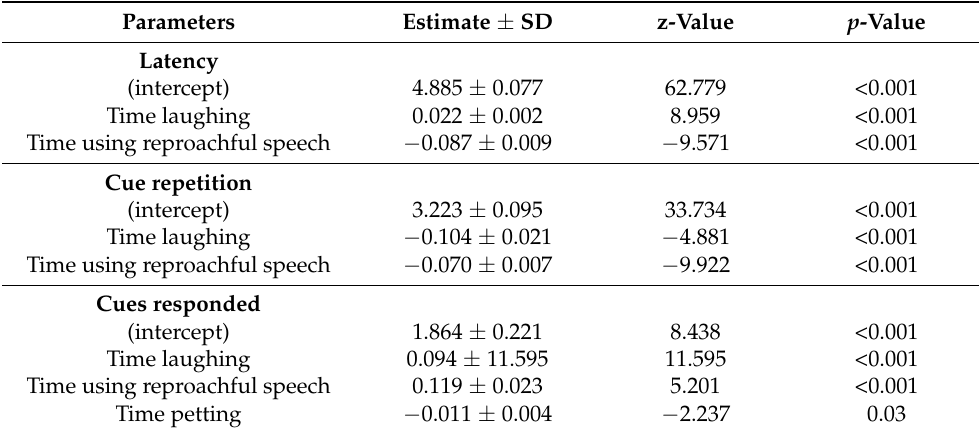
Table 6. Final reduced models (GLMM3) to investigate correlations between trainer identity and behavior and cue repetition, latency in responding to cues, and cues responded to per session during all training sessions with shelter and companion dogs 1 .